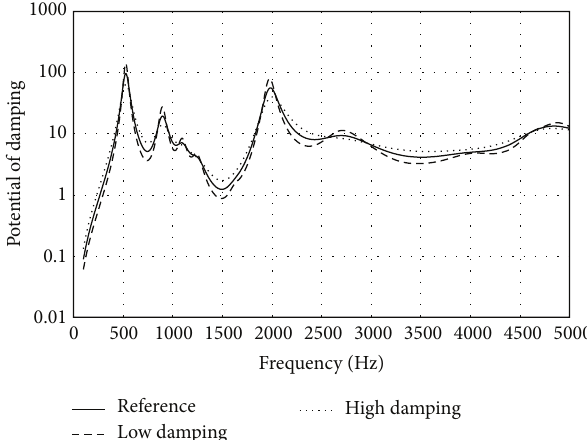
Figure2:Dampingpotentialforviscoelasticmaterialswithdifferent loss